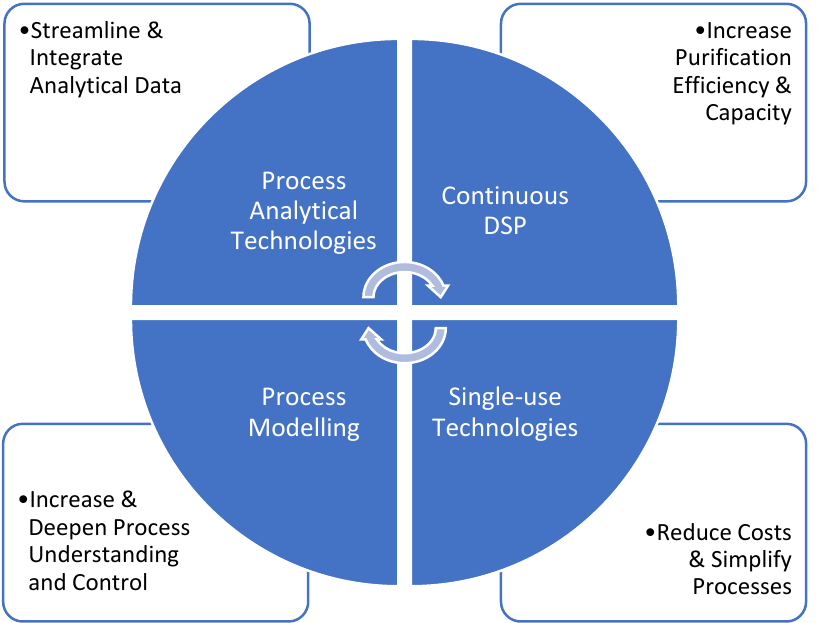
Figure 1. Interrelationship between PAT, continuous DSP, SU technologies and process modelling. For each technology, the primary driver for increasing adaptation is indicated.